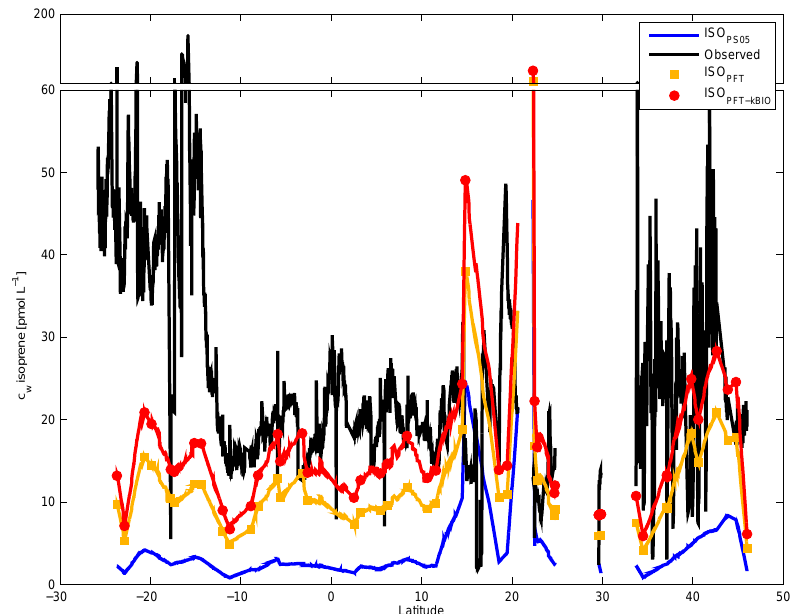
Figure 4. Comparison of in situ measured isoprene (black) with model-derived isoprene concentrations for the ANT-XXV/1 cruise using ISO PS05 (blue), ISO PFT (orange), and ISO PFT- k (red). Squares and circles indicate direct measurements; solid lines are interpolated BIO